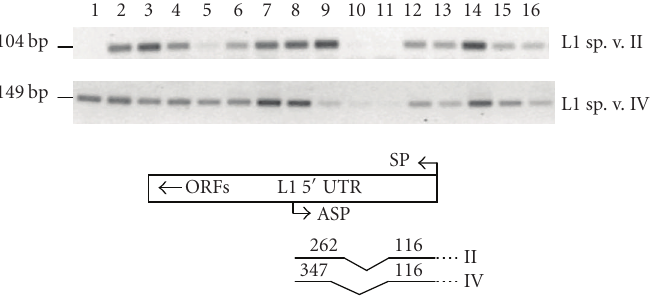
Figure 3: Distribution of L1 splice variants II and IV. The presence of splice variants was estimated by RT-PCR in 16 normal human tissues (numbered as in Figure 1 legend) using a reverse primer designed to hybridize to the junction of exons 1 and 2. The schematically represented splice variants II and IV use a common splicing acceptor site at position +116 and splicing donor sites located at positions +262 and +347, respectively [2]. SP stands for L1 sense promoter; sp v stands for splice variant.